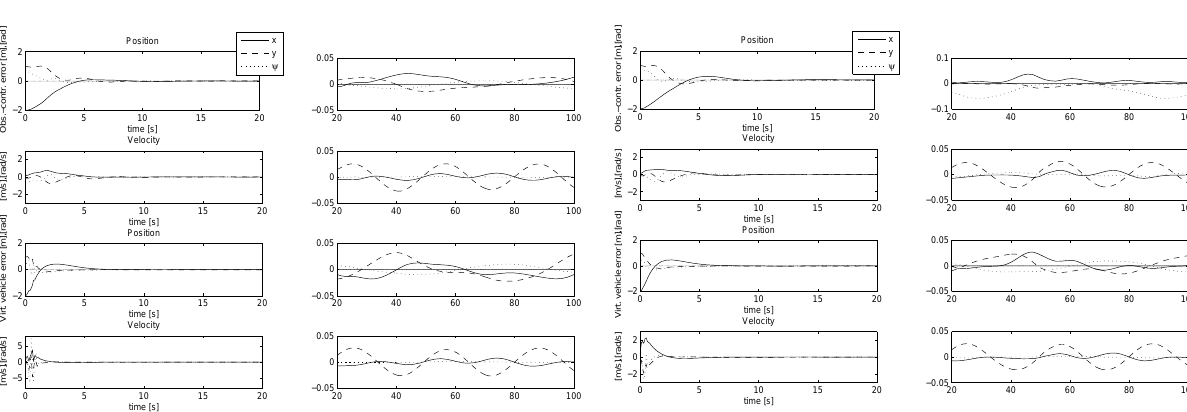
Figure 4: Performance of the dynamic observer scheme (top two rows) and kinematic observer scheme (bot- tom two rows) under model parameter errors.